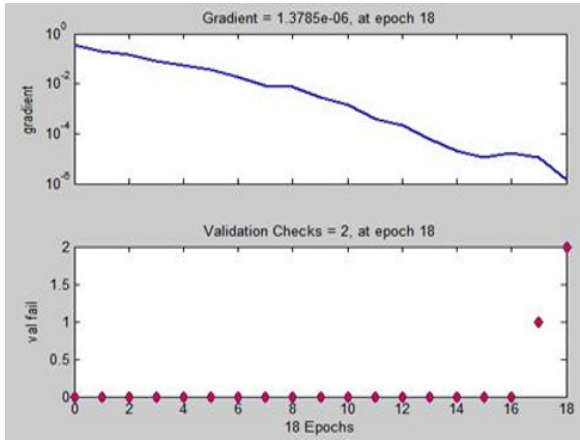
Fig 9 : Training State The error histogram indicates the distribution of errors during testing instances in a neural network. The figure indicates the errors histogram while running our data.